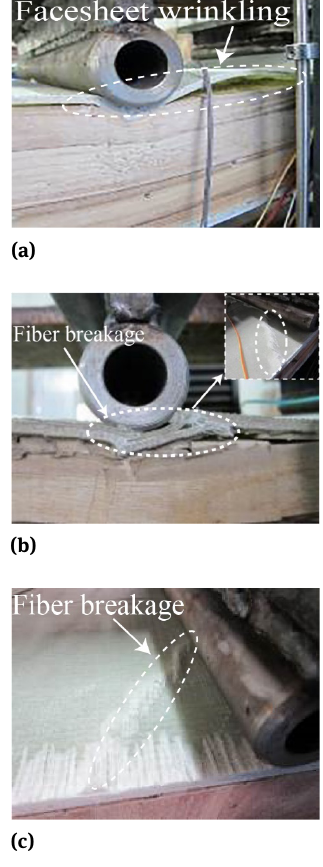
Figure 9: The failure modes of the wood core sandwich panels. (a) PA-80, (b) PA-120, (c)